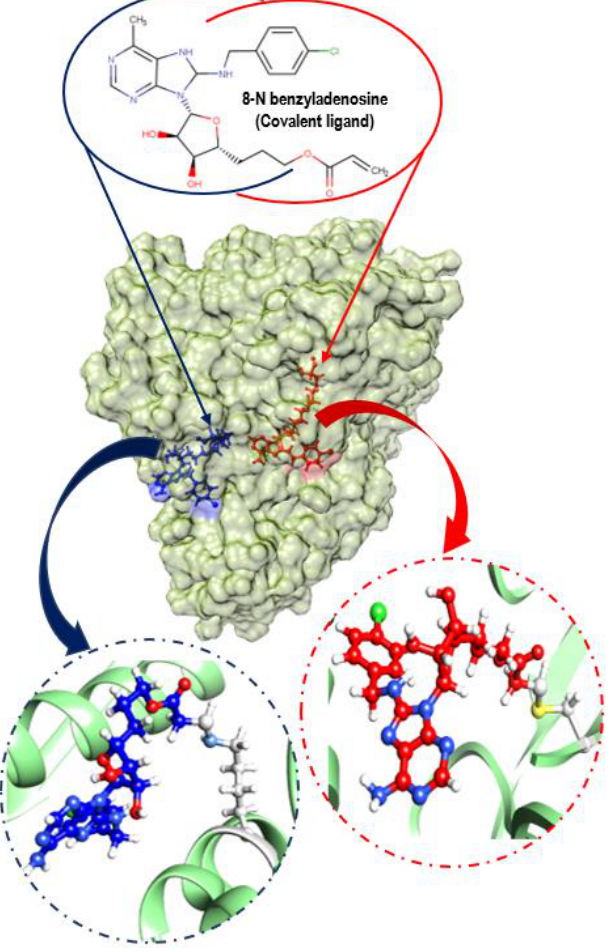
Figure 3. Surface view of HSP72 covalently bonded with 8-N-benzyladenosine inhibitor via a cysteine residue (red) and a lysine residue (navy-blue) with different binding pocket. A close view of two covalent bonds (yellow color cysteine residue bonding and light blue for lysine residue bonding).